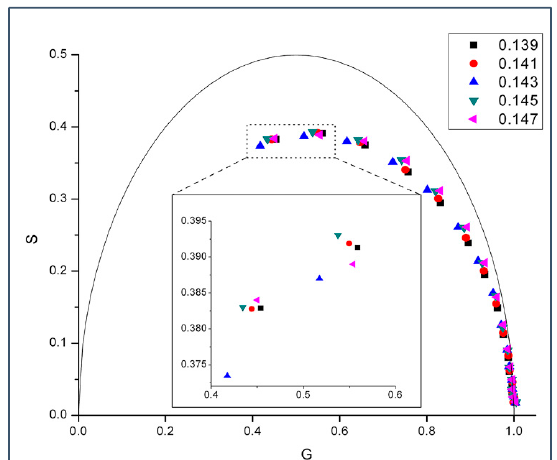
Figure 2. Phasor plot of gramicidin fluorescence lifetime in gD/DMPC MLVs with varying gD mole fractions ranging from 0.139–0.147. Samples were measured at 45 °C using 15 different modulation frequencies: (from left to right) 200.00, 143.94, 103.59, 74.55, 53.65, 38.61, 27.79, 20.00, 14.39, 10.36, 7.46, 5.37, 3.86, 2.78, and 2.00 MHz. The semi-circular arc is called the “universal circle” [21]. Inlet: enlarged phasor data measured at 200.00 and 143.94 MHz; the relative errors of G (=M cos φ ) and S (=M sin φ ) are: ∆ G = 0.00097–0.001 (200 MHz) and 0.0013–0.00143 (143.9 MHz), and ∆ S = 0.00097–0.00101 (200 MHz) and 0.00099–0.00101 (143.9 MHz).